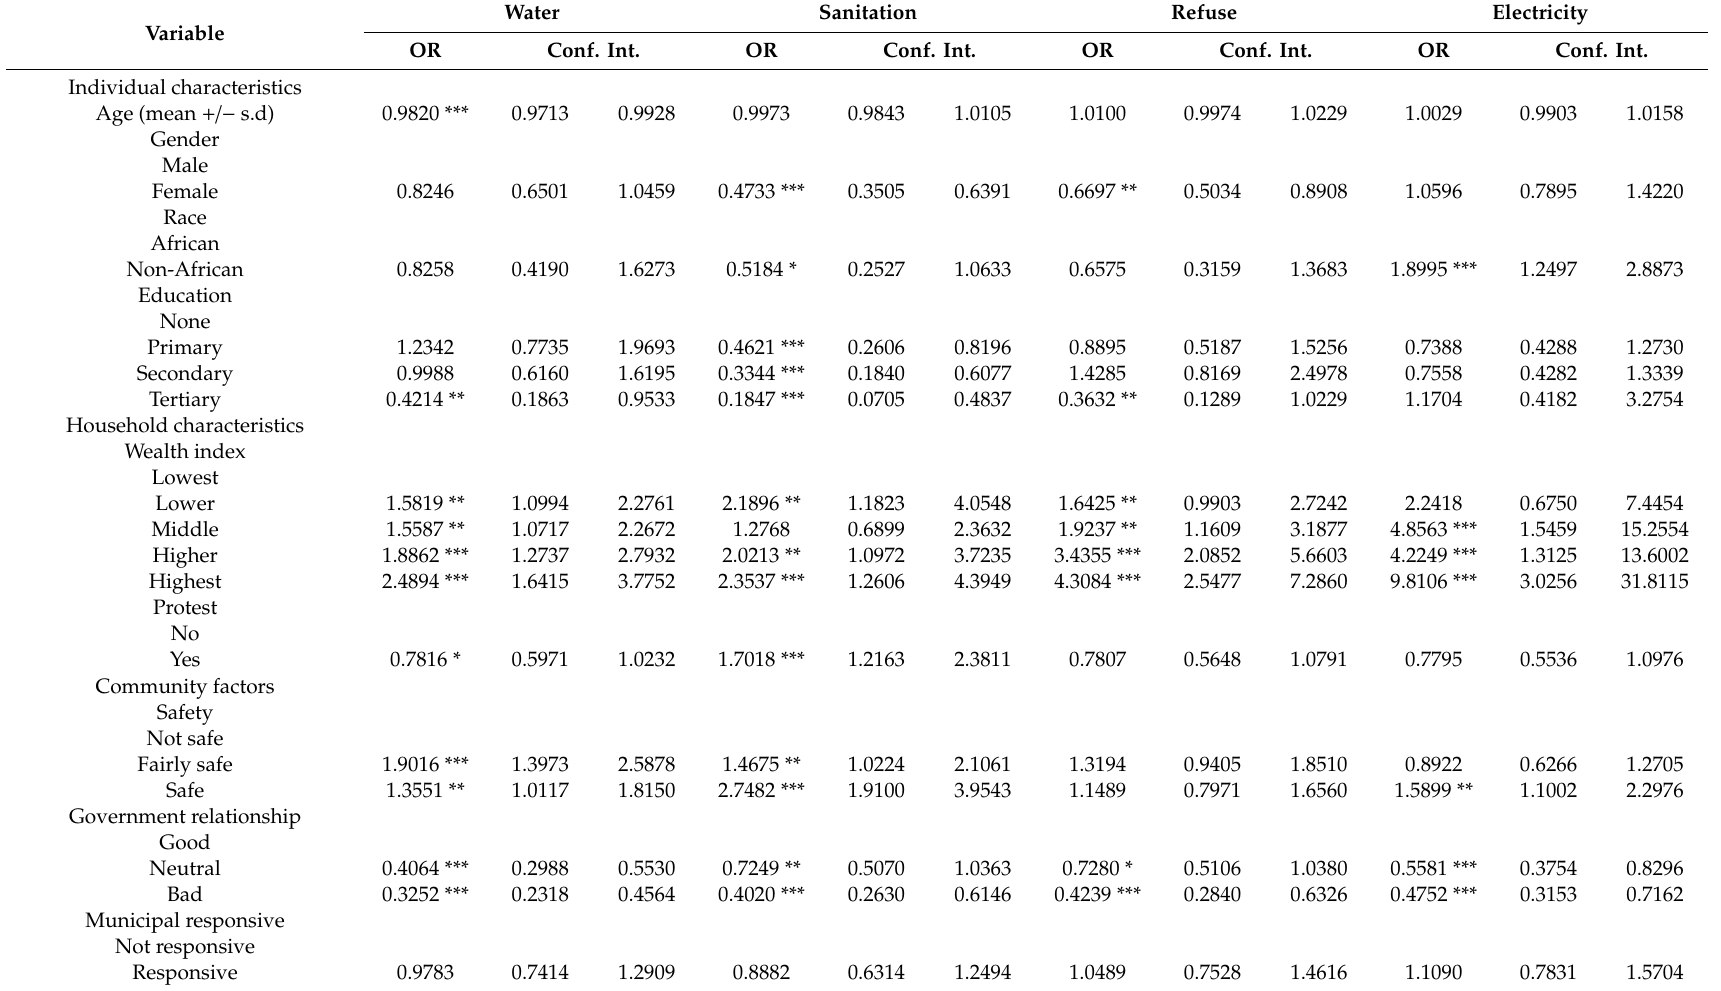
Table 5. Logistic regression analysis of factors associated with satisfaction in basic